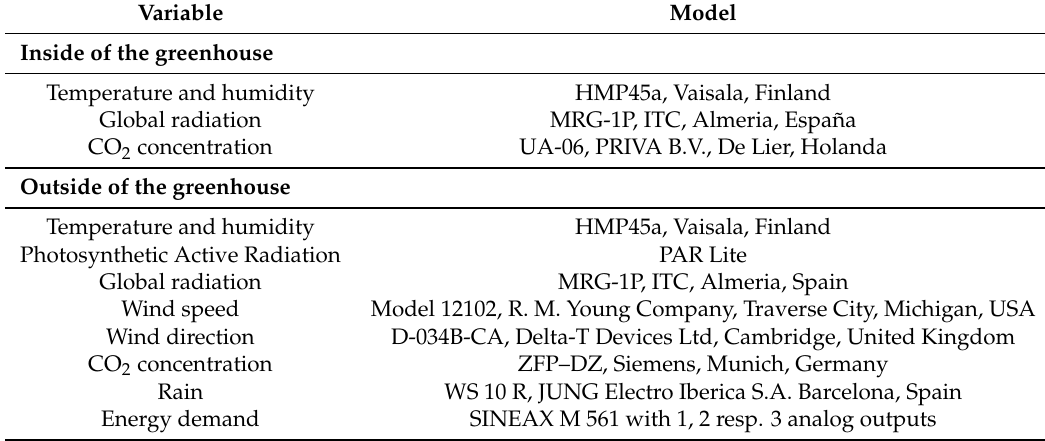
Table 1. Sensory system installed in the